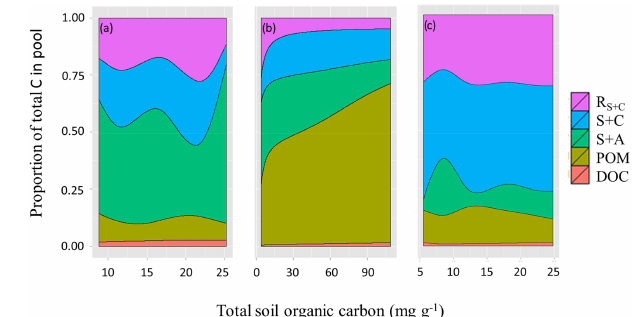
Figure 11. Proportion of total soil carbon in the different pools for the three soil groups varying as a function of their SOC content. (a) LAC, (b) arenic and (c) HAC soils. Dissolved organic carbon (DOC), particulate organic matter (POM), sand and aggregates ( S + A ), silt and clay ( S + C ), and resistant SOC associated with silt and clay